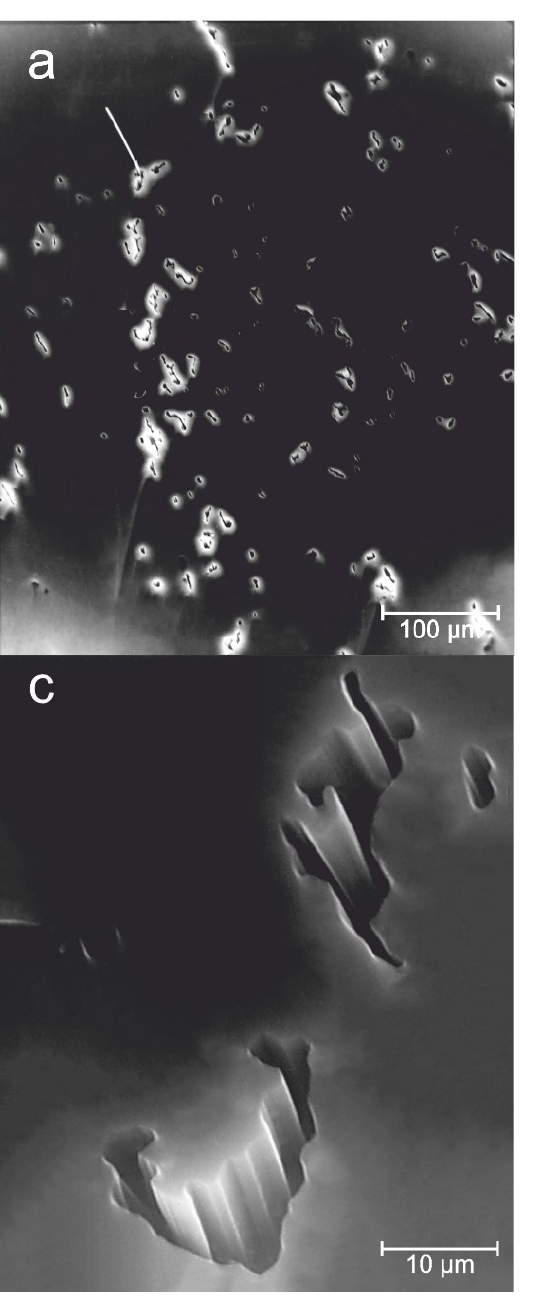
Figure 10. BSE-images of “horsetail” inclusions in fresh chipping of the demantoid: ( a ) point-like hollow channels (one contains a needle-like inclusion of an unknown mineral); ( b ) slit-like hollow channels; ( c ) morphology of cross sections of point and slit-like channels; and ( d ) mineral inclusion in a hollow channel (fragment of Figure 10a).